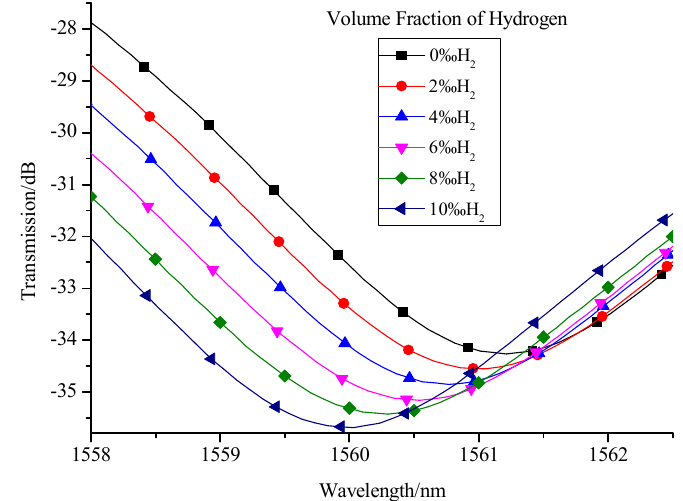
Figure 7. Experimental spectra of sensor for different hydrogen concentrations.